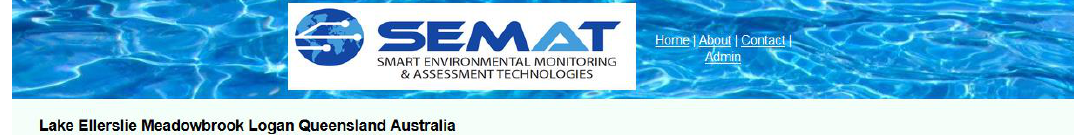
Figure 8. Charted Data from a Buoy.